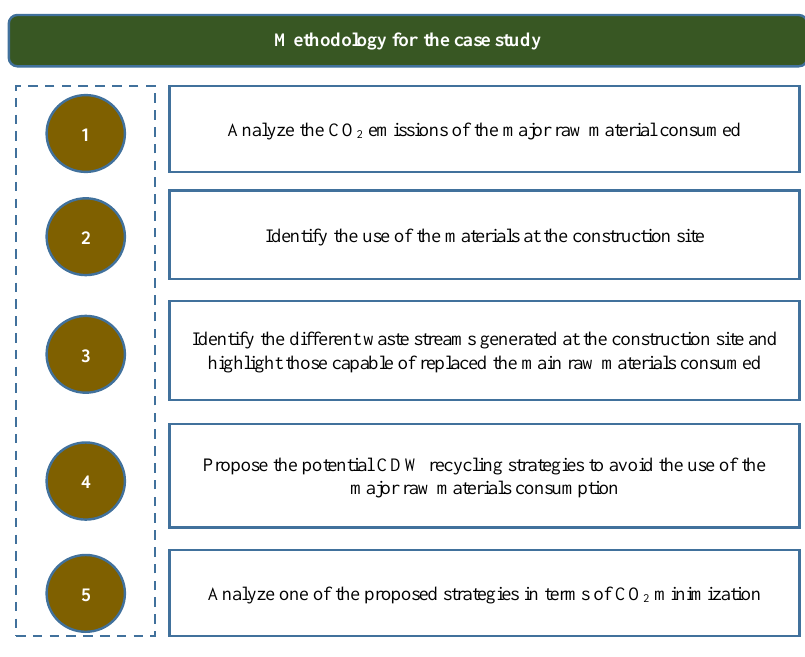
Figure 1. Research Methodology.